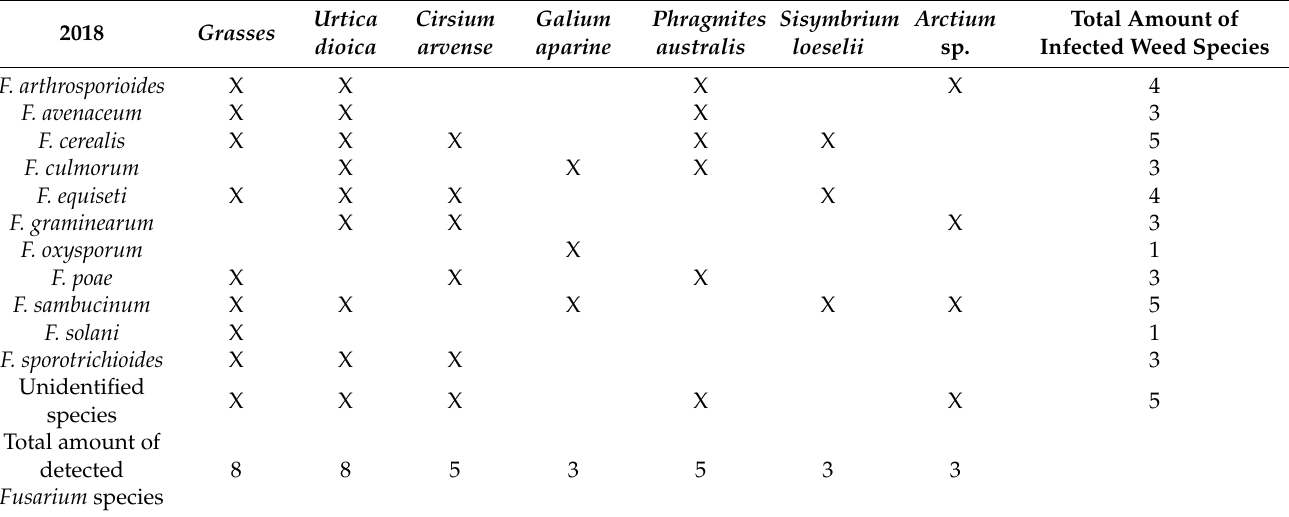
Table 3. Fusarium species isolated from all sampled plants at the edges of all kettle holes investigated in 2018. Sampling months are summarized. X stands for the presence of one specific Fusarium species (11 in total, column 1) on one plant species/family (line 1). Grasses are a mixture of the species Arrhenatherum elatius , Bromus sterilis , Calamagrostis epigejos , Dactylis glomerata , Elymus repens , Lolium perenne , Poa trivialis in different